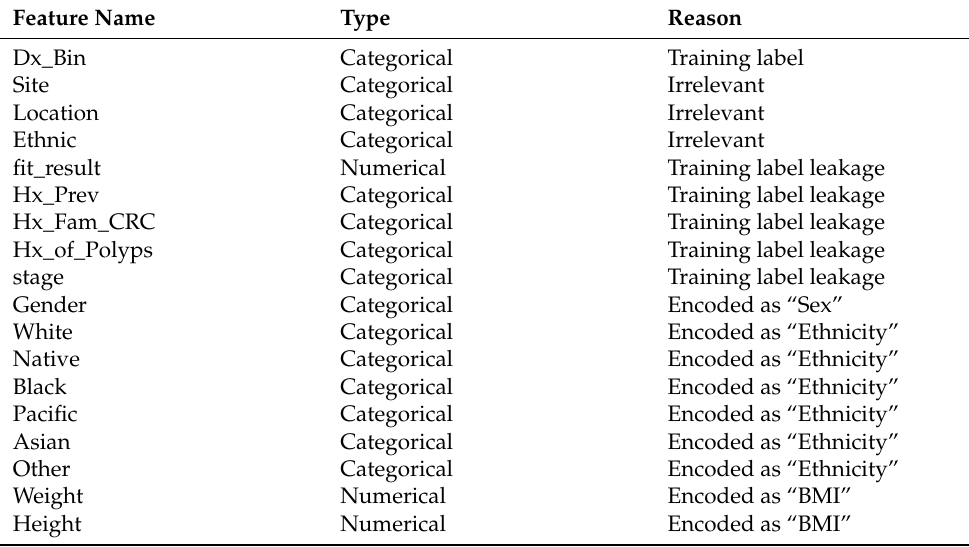
Table A3. List of features removed from the colorectal cancer clinical view